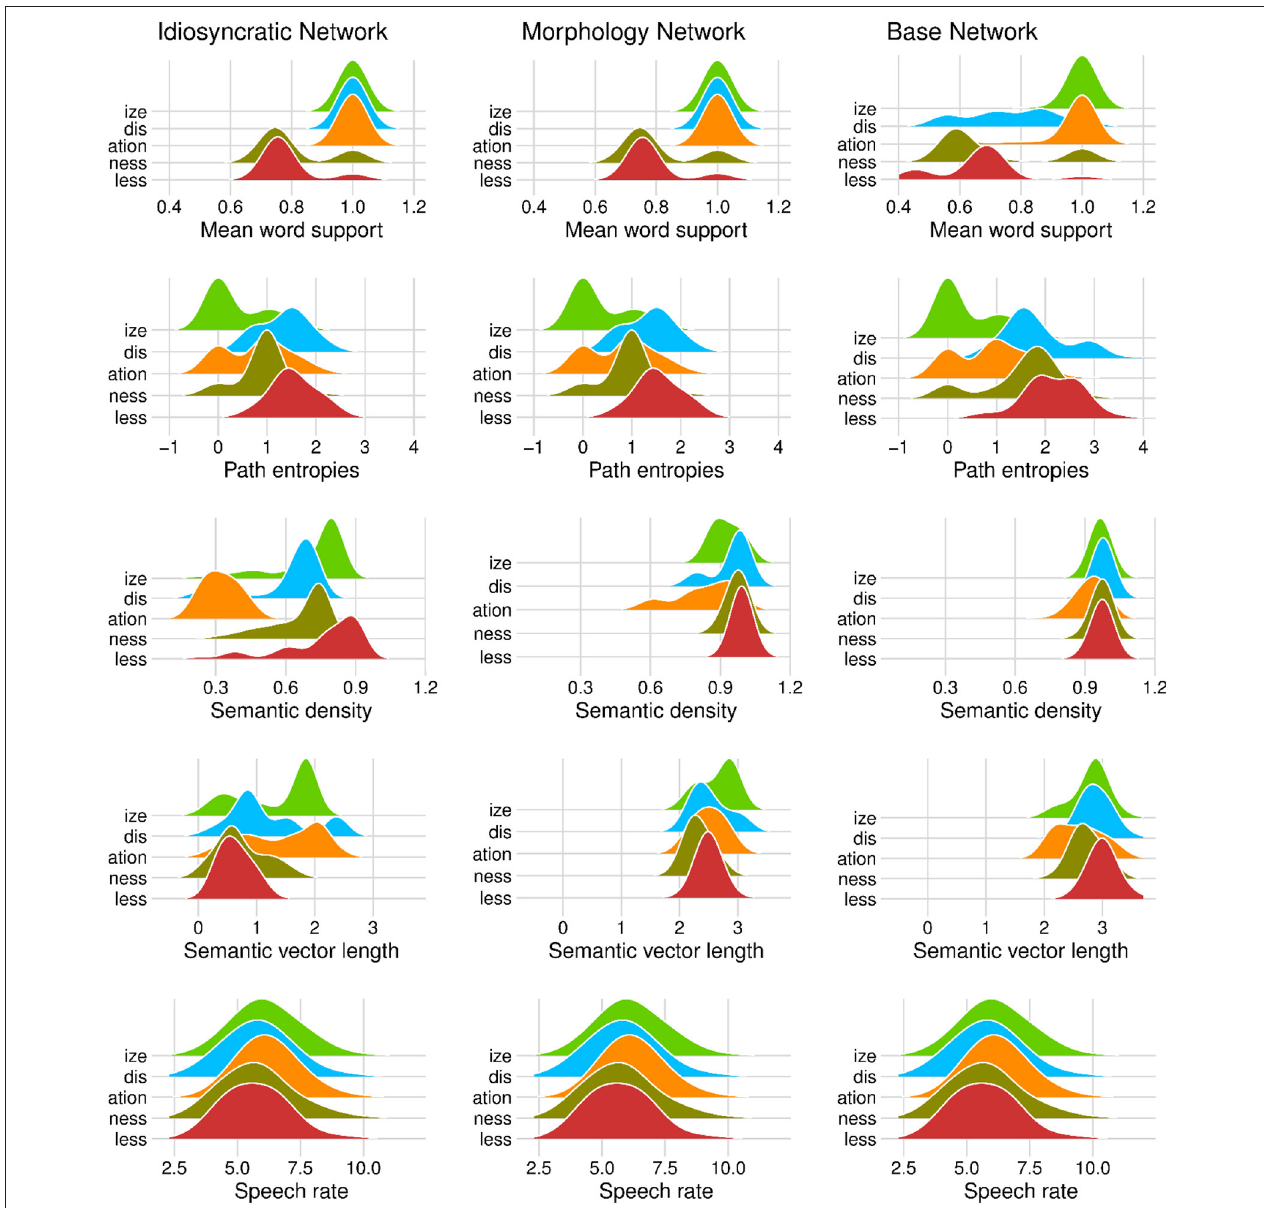
FIGURE 5 | Density distributions of variables by derivational function in the Idiosyncratic Network models (left column), the Morphology Network models (middle column), and the Base Network models (right column). Note that in the first two panels in the top tow, the density curves around 1.0 are calculated over a single